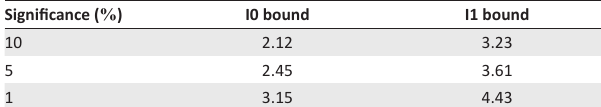
TABLE 4: Critical value